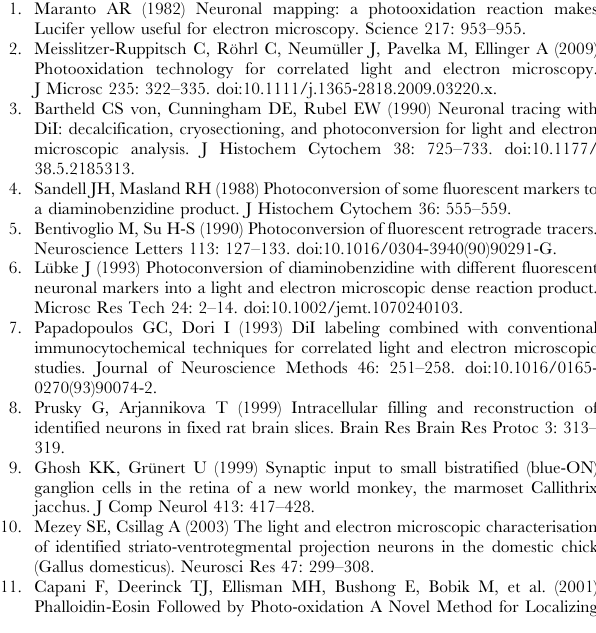
Figure S1 Representative photomicrographs of DiI- filled neocortical neurons before the submission of the tissue samples to the photooxidation reaction. Observe that the neuronal processes are well filled, a factor that is paramount for a good DAB staining in the subsequent photooxidation reaction. Scale bars correspond to 20 m m. A and B: Photomicrographs (40 6 objective lens) of neocortical neurons filled with DiI in samples of developing rat neocortex. Figure S2 Representative photomicrographs of DiI- filled human retinal neurons before and after the submission of the tissue samples to photooxidation reaction with our novel method. Note that we were able to image the same group of cells under fluorescent microscopy (before photooxidation) and under light microscopy (after photooxidation). These images illustrate both the reliability of the method and the important advantage of photooxidation in general for studies of cellular morphology, given that the resolution for visualizing neuronal processes is greatly increased by this process. Colored arrows identify specific cells that are present in both panels. Scale bars correspond to 50 m m. A: Photomicrograph (20 6 objective lens) of neurons filled with DiI in samples of post-mortem human retina. B: Photomicrograph (20 6 objective lens) of the same neurons imaged in Panel A after submitting the tissue sample to photooxidation reaction with our novel apparatus. Figure S3 Representative photomicrographs of DAB- stained human retinal neurons photooxidized with our new illumination method and with a traditional